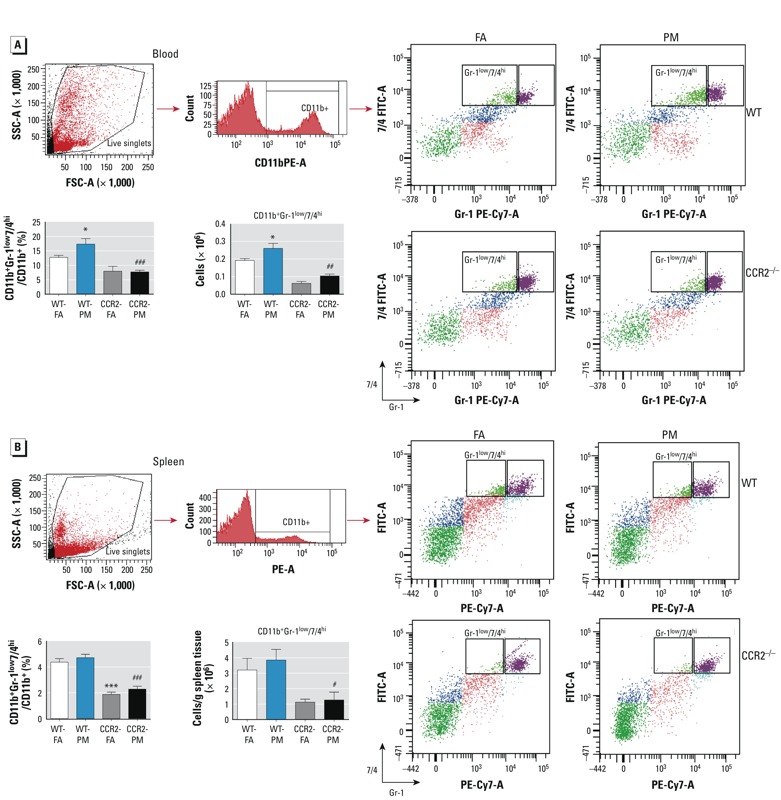
Representative flow cytometric dot plots and analysis showing effects of PM2.5 exposure and HFD on inflammatory monocytes in blood (A) and spleen (B) from WT and CCR2–/– mice; animals were exposed to PM2.5 or FA for 17 weeks. Abbreviations: FSC, forward scatter; SSC, side scatter. Data were analyzed by relative percentage or absolute cell counts and are presented as mean ± SE of 7–9 mice/group).
*p < 0.05, and ***p < 0.001, compared with the WT‑FA group. #p < 0.05, ##p < 0.01, and ###p < 0.001 for CCR2‑PM compared with the WT‑PM group.